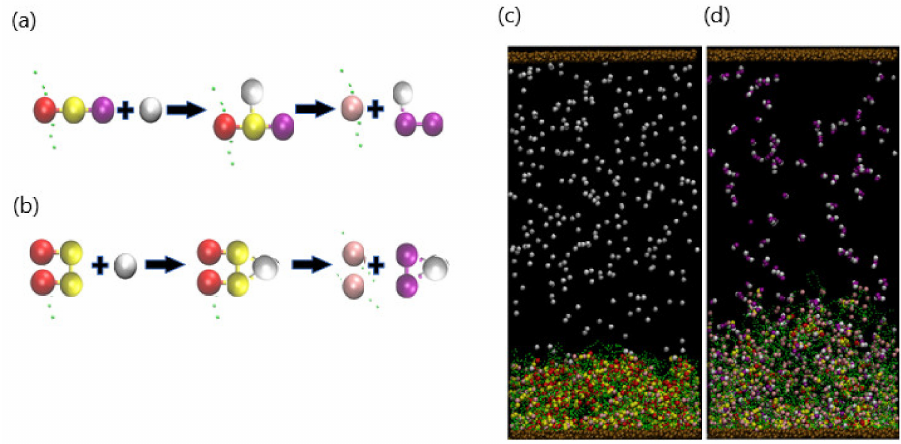
Figure 5. ( a ) Reactions between EDTA particle (white) and single-binding complexation. ( b ) . Re- actions between strong-binding particle and double-binding complexation. ( c , d ) . Snapshots of the system after adding EDTA ( N EDTA = 300) at ( c ) t = 10 4 and ( d ) t = 10 6